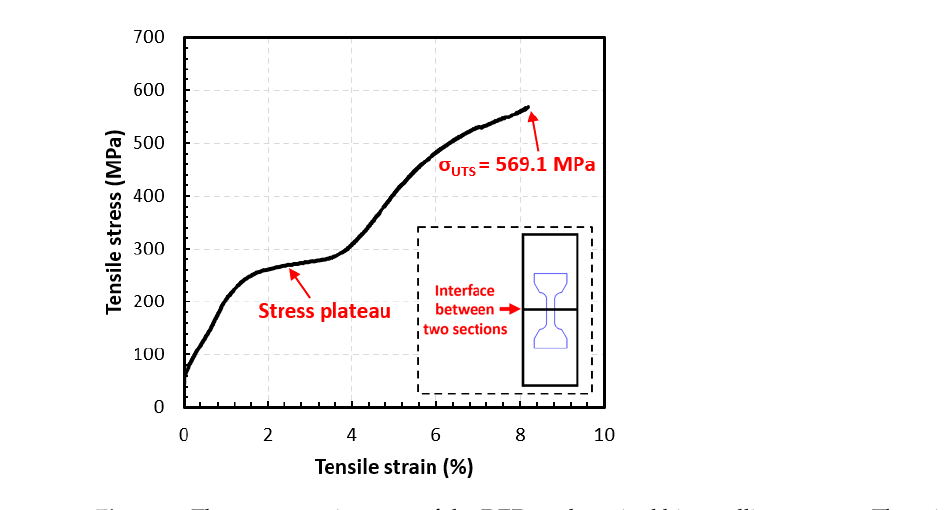
Figure 9. ( a , b ) Dimple-like ductile area of the fracture surface. ( c , d ) Brittle area of the fracture sur- face. ( e ) High magnification image of ( d ) in long, dashed rectangular box. ( f ) Element mapping of Ti in ( e ). ( g ) Element mapping of Ni in ( e ). ( h ) Element mapping of Cu in ( e ).